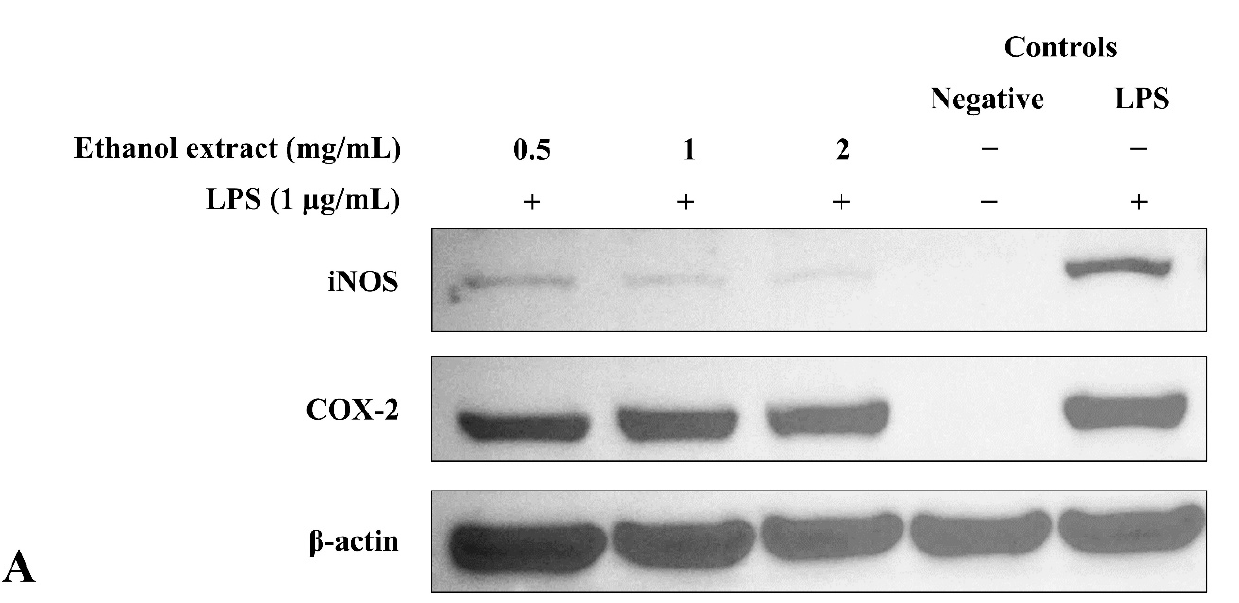
Figure 4. Inhibitory activity of S. platensis ethanol extract on the proinflammatory mediator and cytokines production in LPS-induced BV2 microglia. Dose-dependent effects were observed on the production of ( A ) PGE 2 , ( B ) TNF- α and ( C ) IL-6. The inhibitory activities were expressed as a percentage of the negative control. Data represented the mean ± SE ( n = 3). *** p ≤ 0.001 significant difference in inhibitory activity relative to the LPS control by Dunnett’s multiple comparison test.